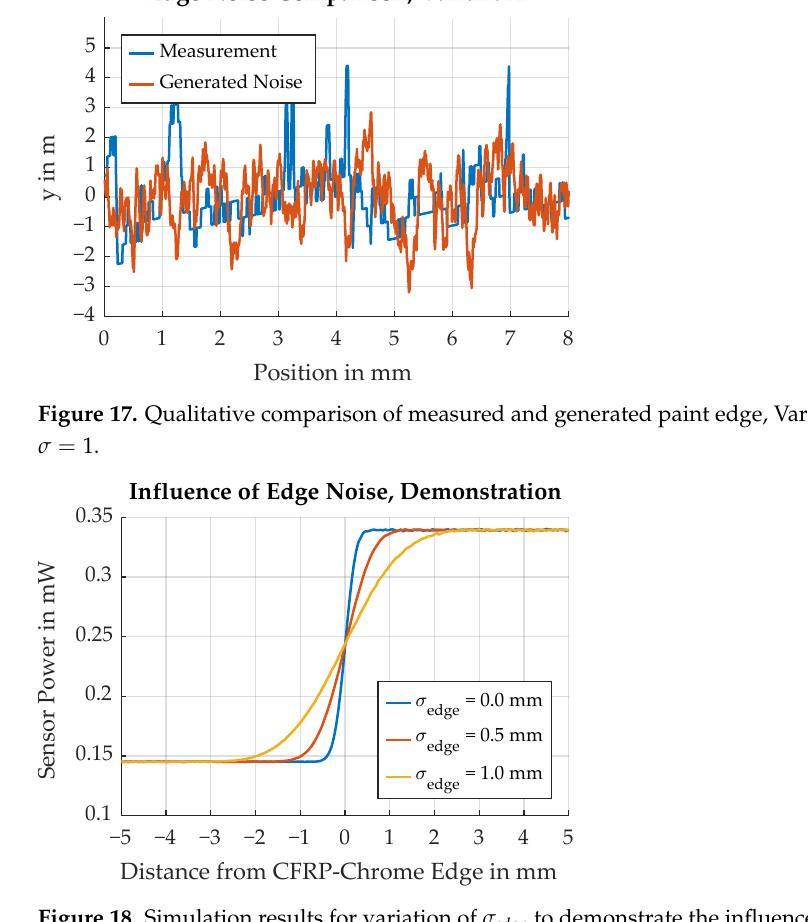
Figure 18. Simulation results for variation of σ edge to demonstrate the influence of edge noise on the transition